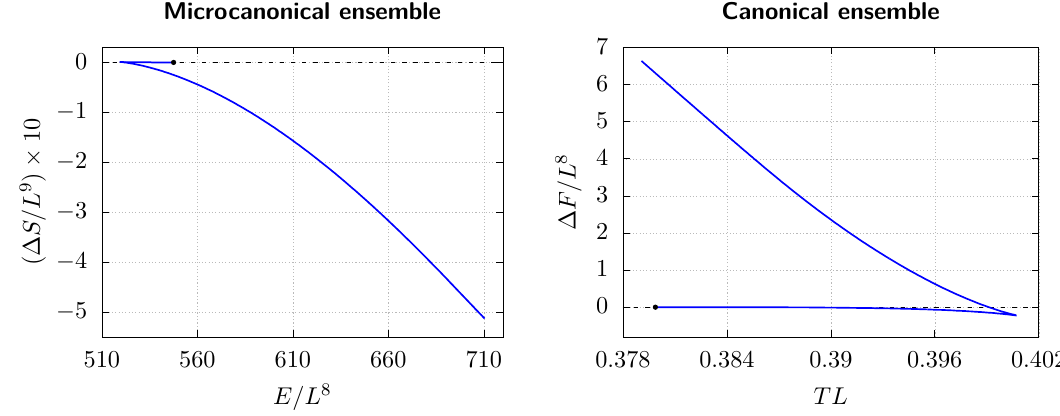
Figure 6. Phase diagram in the microcanonical ensemble (left) and canonical ensemble (right), of ‘ = 2 − lumpy black holes. The GL threshold point is indicated with a black solid disk. The zero is taken to be the Schwarzschild-AdS 7 black hole phase. The ‘ = 2 − dominate over the 4 × S small Schwarzschild-AdS 7 black hole near the GL threshold point in both ensembles. In the 4 × S canonical ensemble, thermal AdS 7 is the dominant phase in this range of 4 × S